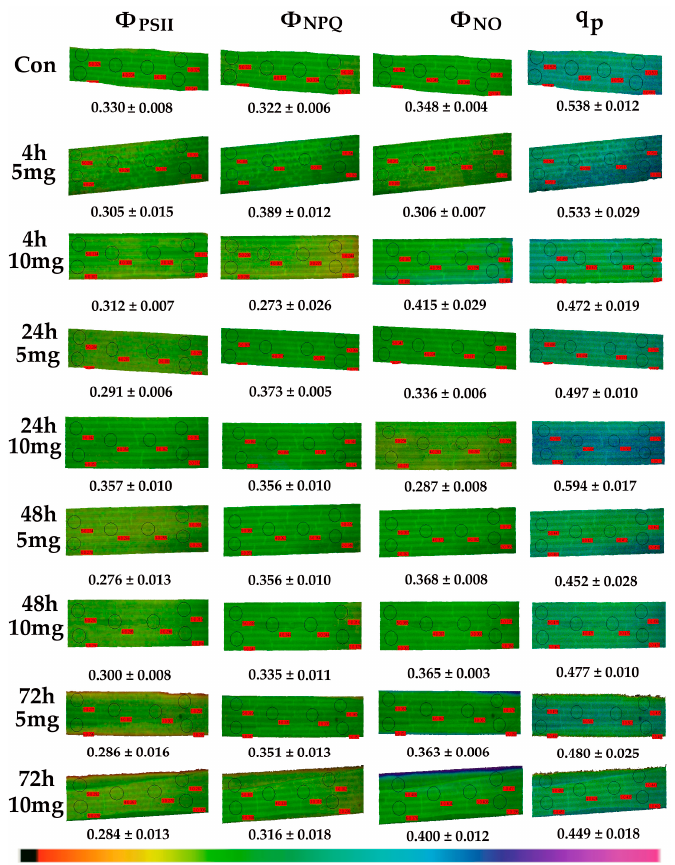
Figure 9. Representative chlorophyll fluorescence images at 200 µ mol photons m − 2 s − 1 actinic light of Φ PS ΙΙ , Φ NPQ , Φ NO , and q P ; of C. nodosa control leaf blades and leaf blades exposed to 5 mg L − 1 and 10 mg L − 1 ZnO NPs for 4 h, 24 h, 48 h and 72 h. The colour code depicted at the bottom of the images ranges from black (pixel values 0.0) to purple (1.0). The six areas of interest are shown. Average values are presented for each photosynthetic